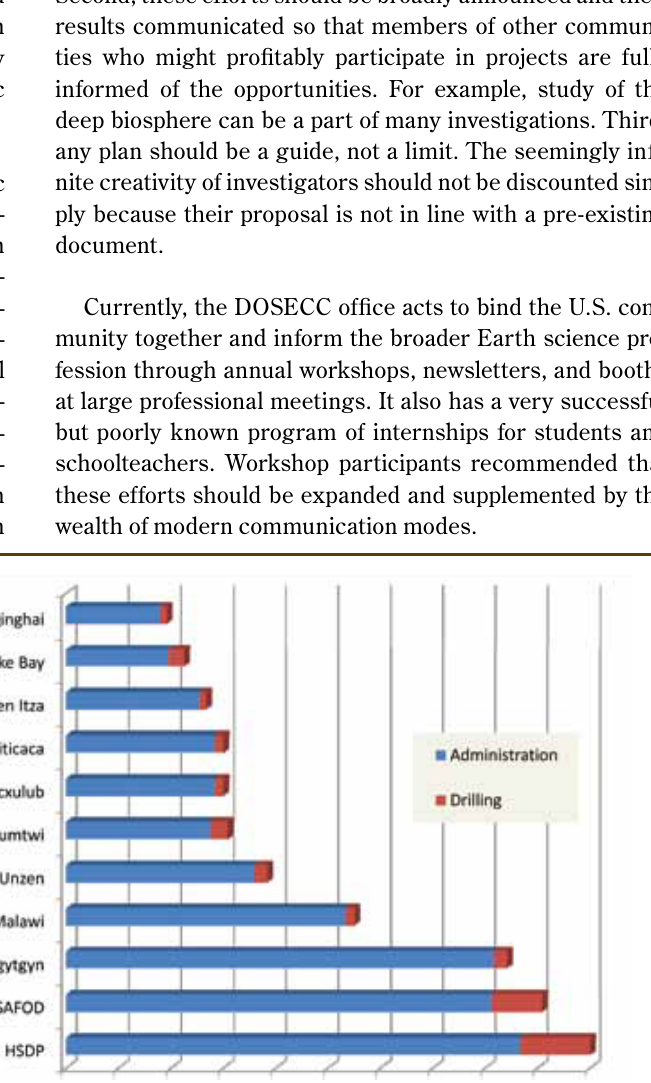
Figure 1. Comparison of drilling time to preparation time for representative projects. Administrative time includes the time from first workshop or first contact with DOSECC office until drilling actually begins. Projects undergo a year or more of planning and refinement before that occurs. The spectacle of 4–10 years of delay before operations begin effectively precludes young U.S. investigators from undertaking continental scientific drilling efforts (courtesy of Dennis